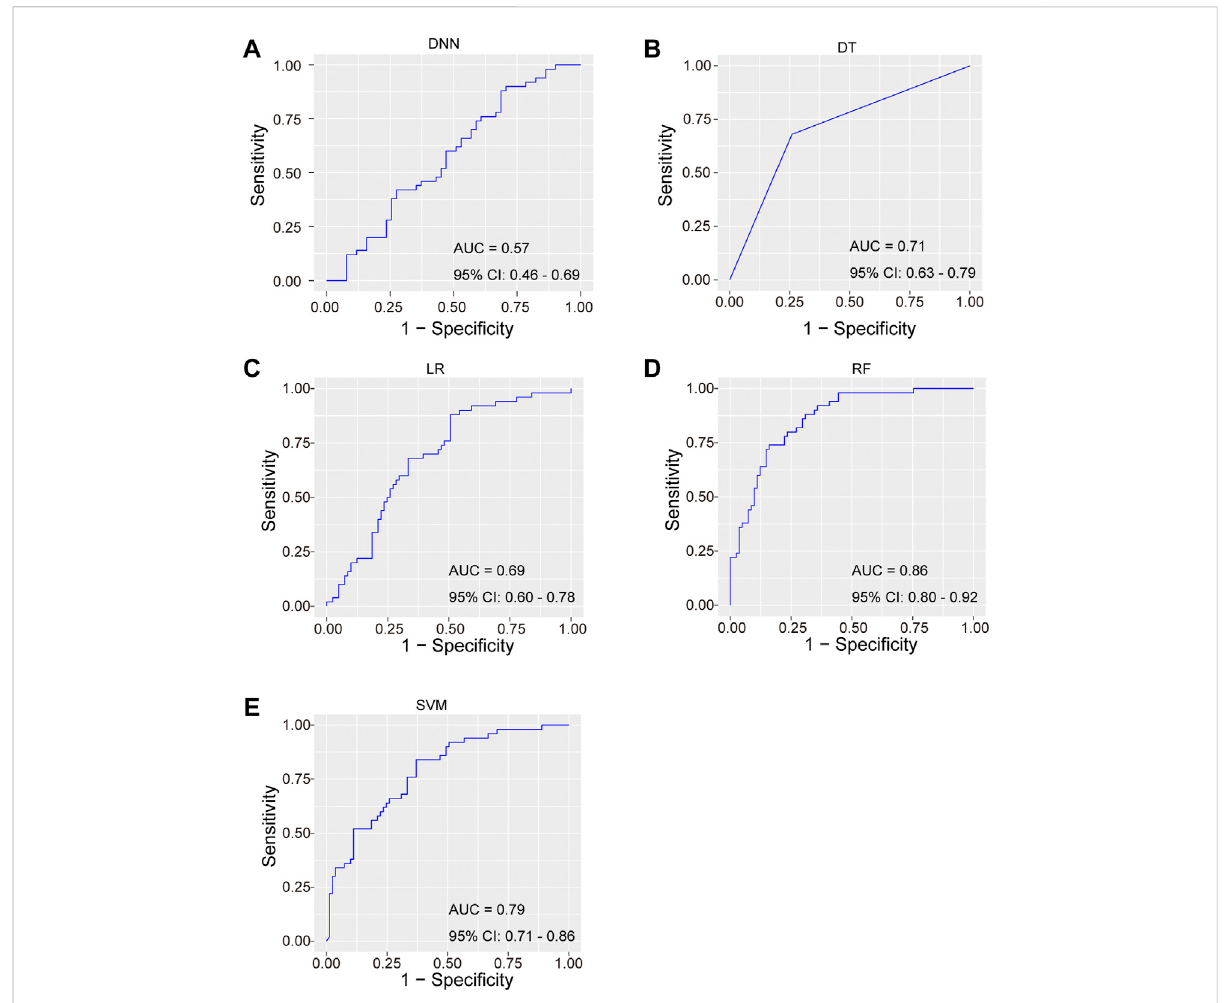
FIGURE 2 Receiver operating characteristics (ROC) curves for the fi ve machine learning models. (A) DNN; (B) DT; (C) LR; (D) RF; (E) SVM.